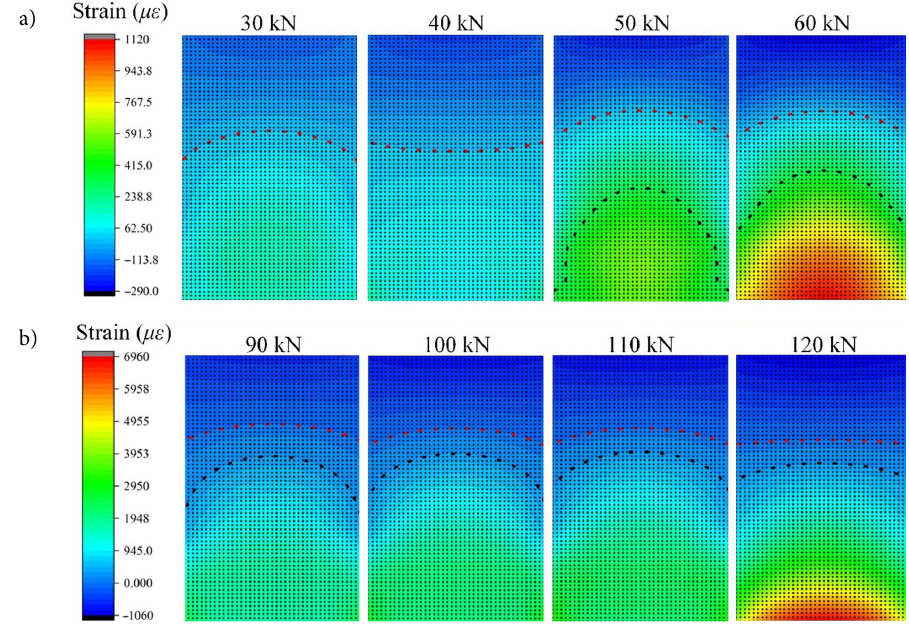
Figure 7. The strain contour maps of BB5: a – The strain contour maps corresponding to the characteristic load P; b – The strain contour maps corresponding to the characteristic